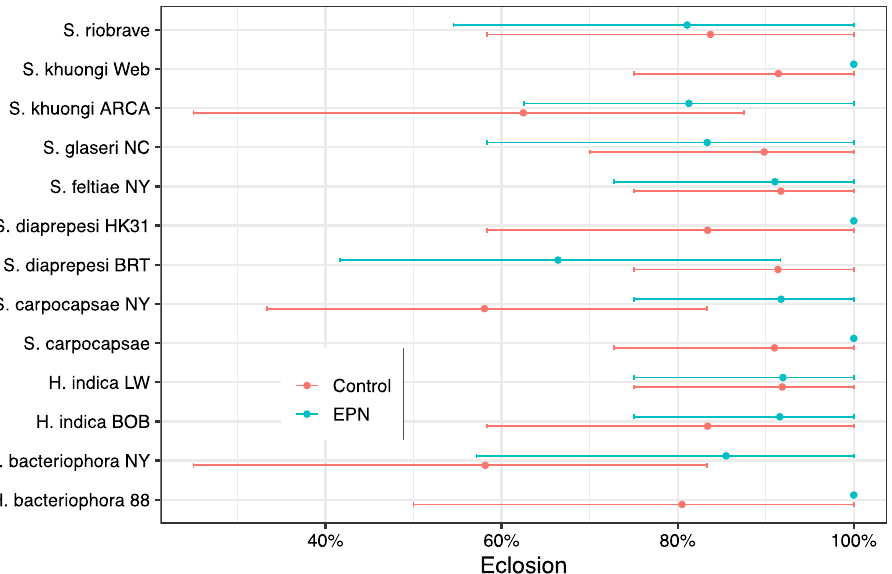
Figure 2. D. antiqua pupal eclosion following exposure to strains of entomopathogenic nematodes. The percentage of eclosion was high throughout the trial; most pupae successfully eclosed and made it to the adult lifestage. Inoculation with entomopathogenic nematodes did not cause significant mortality at the pupal nor prevent eclosion. There was no significant effect of strain. Percent eclosion denotes percent of cohort of pupae successfully eclosing to adulthood. Points and errorbars denote mean and bootstrapped 95% confidence intervals respectively.